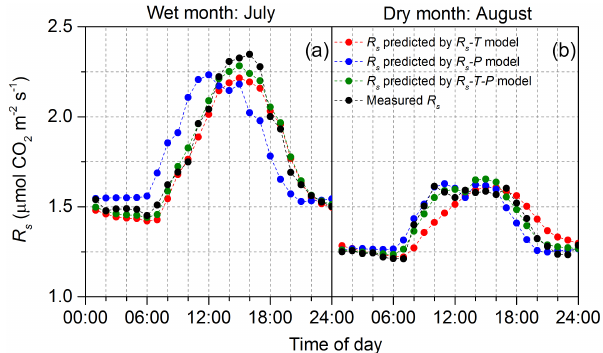
Figure 3. Diel variation of measured soil respiration ( R s ) and mod- eled R s by using temperature and photosynthesis as input variables in the calculation of R s for both a wet and dry month (i.e., July and August, respectively); R s − T function (Eq. 1), R s − P function (Eq. 2), and R s − T − P function (Eq.